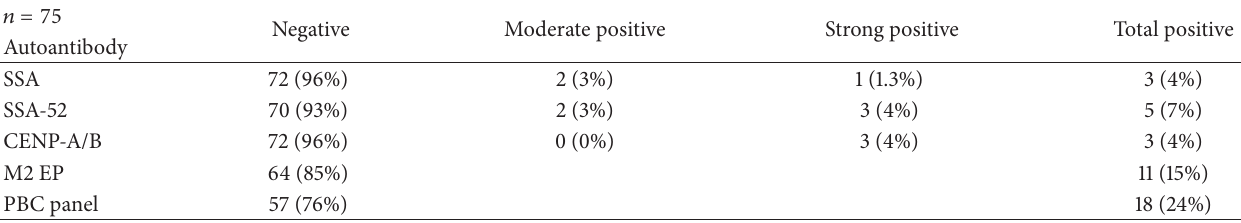
Table 4: Results of selected specific autoantibody results from the CRST population sample.